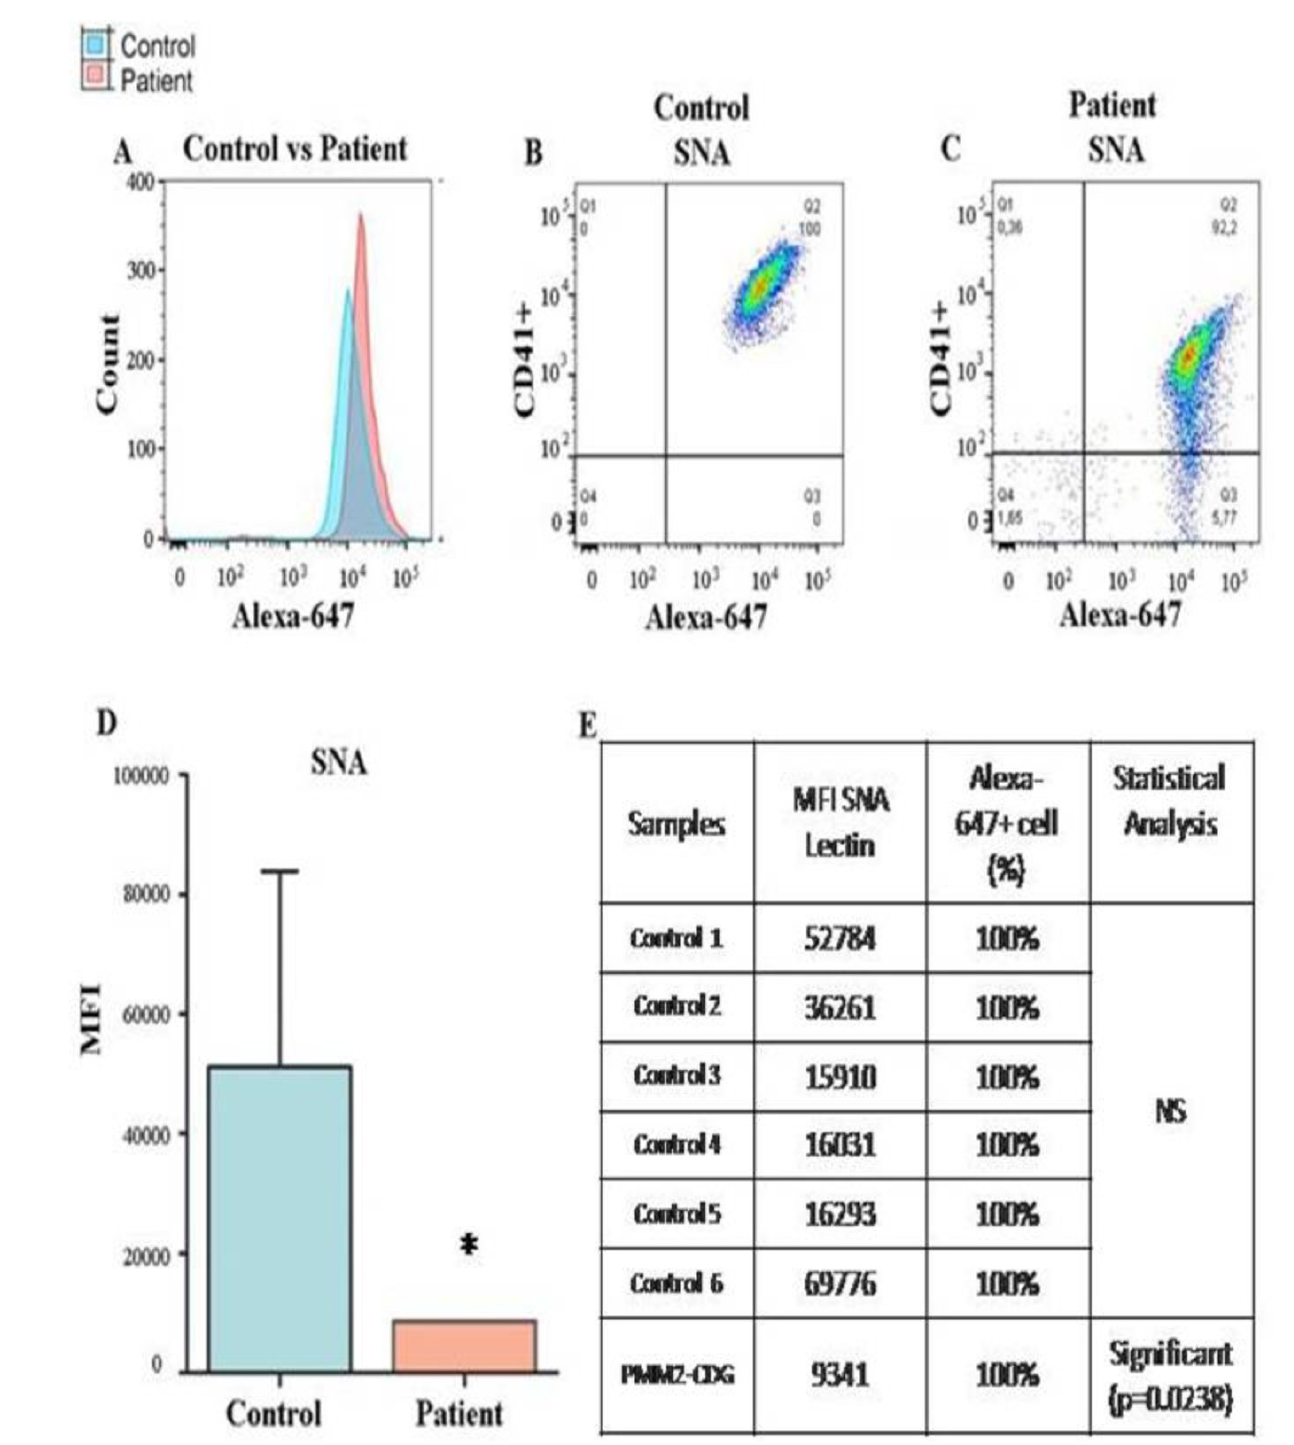
Figure 5. Decreased binding of SNA to PMM2-CDG platelets. A. Platelet populations were gated based on positive CD41-PE staining and SNA lectin binding detected by Alexa Fluor 647-conjugated streptavidin. Representative MFI histogram showing SNA signal distribution in a control and a PMM2-CDG patient PRP sample. B-C. Representative dot plots of CD41 expression vs. SNA lectin signal in control and patient PRP samples. D. SNA-MFI summary data (*=0.0238). E. Summary results. MFI for SNA signal and CD41 + /SNA + platelet counts (%) are indicated for control and PMM2-CDG patient